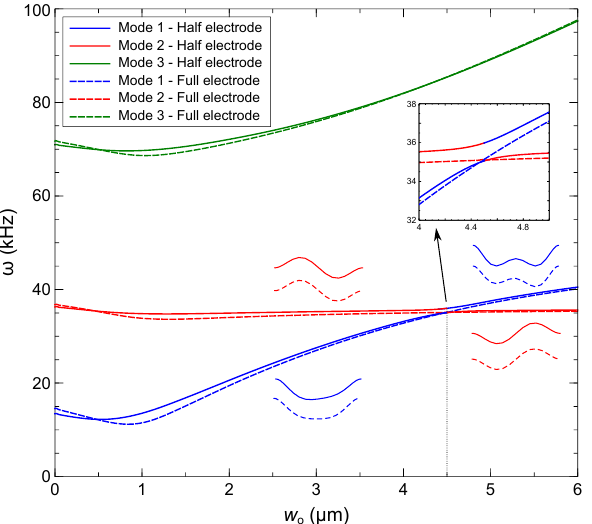
Figure 9. Variation of the first three modes’ natural frequencies with the initial rise w o under a DC voltage of V DC = 15 V applied across the half-electrode (solid lines) and the full-electrode (dashed